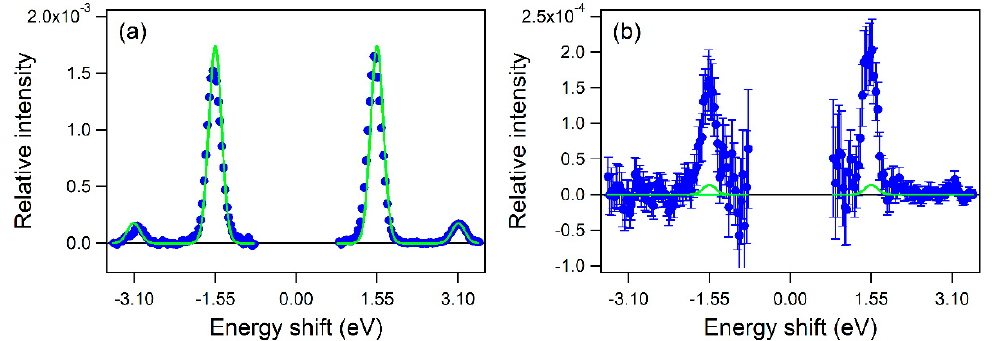
Figure 7. Energy spectra of electrons scattered within the angular ranges of ( a ) 0.1° ≤ θ ≤ 10.0° and ( b ) 0.1° ≤ θ ≤ 0.5° [10]. The blue filled circles are the experimental data and the green solid lines are the simulations based on the Kroll–Watson theory. These spectra were obtained by the background subtraction. The experimental conditions are the same as those in Figure 6.